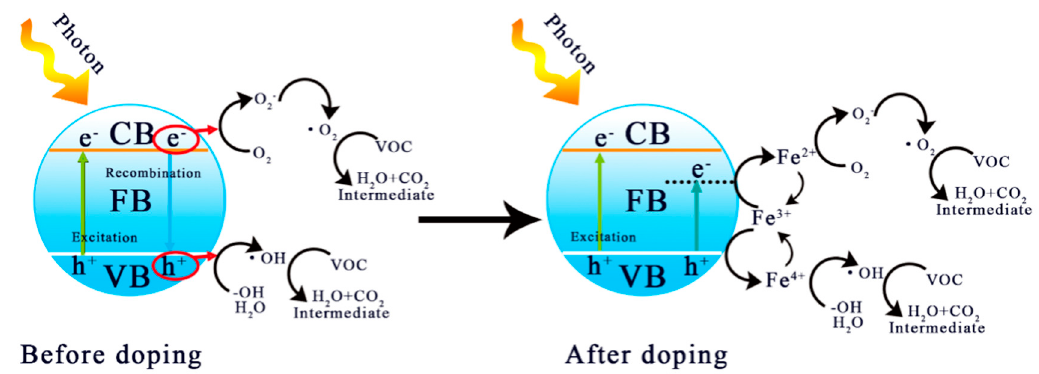
Figure 12. Possible mechanism of photocatalytic enhancement of Fe 3+ -doping.